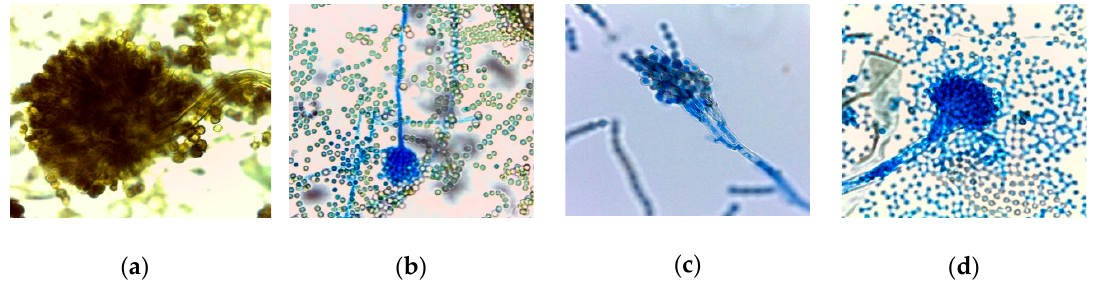
Figure 1. Asexual reproduction structures of lactophenol cotton blue stained fungal species examined by a light microscope with a total magnification of 1000x; ( a ) Aspergillus brasiliensis DSM1988, ( b ) A. flavus MUCL11945, ( c ) Penicillium roqueforti DSM1079, ( d ) Aspergillus fumigatus